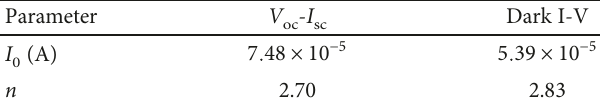
Table 2: I and n obtained from V 0 that estimated from dark I-V measurements of the mono-Si cell.